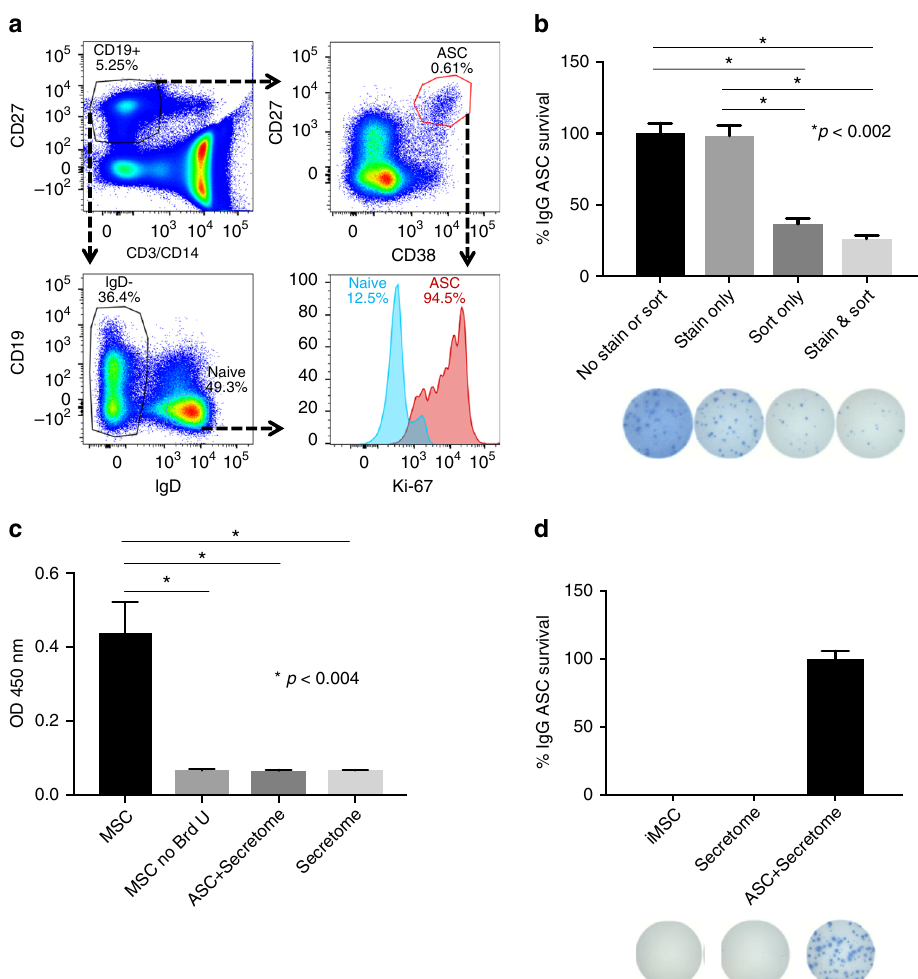
Fig. 2 MSC secretome restores the secretory function of sorted ASC. a Flow cytometric analysis of intracellular Ki-67 expression of blood ASC. b Effects of antibody staining and sorting on ASC survival and function. IgG Elispot assays were performed on the same number of PBMC that were untouched (No Stain or Sort), only stained with antibodies and not FAC sorted (Stain), only FAC sorted and not stained with antibodies (Sort), or both stained and FAC sorted (Stain & Sort). Maximal number of IgG Elispots occurred in the No Stain or Sort wells and normalized to 100% (* p < 0.002; ANOVA). c BrdU incorporation of MSC and ASC. BrdU was added to ASC cultured in the secretome or secretome alone. Triplicate cultures of dividing noniMSC alone with and without BrdU served as positive and negative controls. BrdU was also added to conditions of secretome alone or secretome with ASC (* p < 0.004; ANOVA). This fi gure is representative of three experiments. d No BM-derived ASC contamination in iMSC co-cultures or MSC secretome. IgG Elispot assays were performed on iMSC (iMSC) or MSC secretome (Secretome). Blood ASC in MSC secretome cultures (ASC + Secretome) served as a positive control. Representative images of Elispot wells are shown